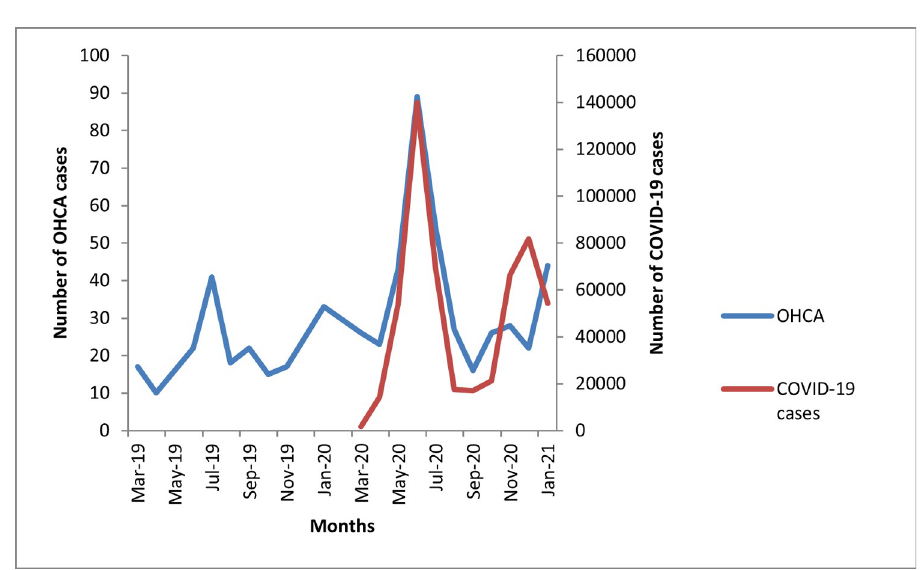
Fig 3. COVID-19 cases in Pakistan, and DOA at study-hospital between pre-pandemic vs. pandemic